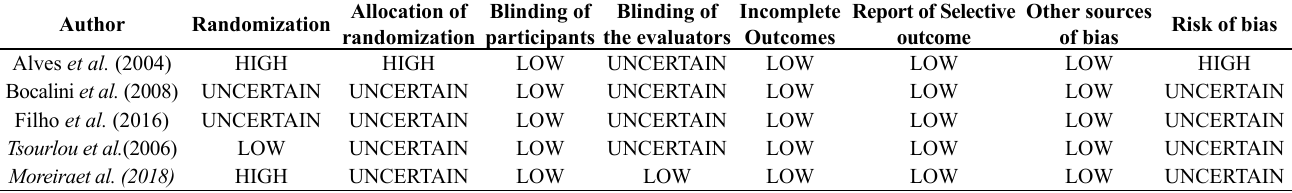
Table 3. Risk of Bias analysis through the Cochrane Collaboration Tool Author